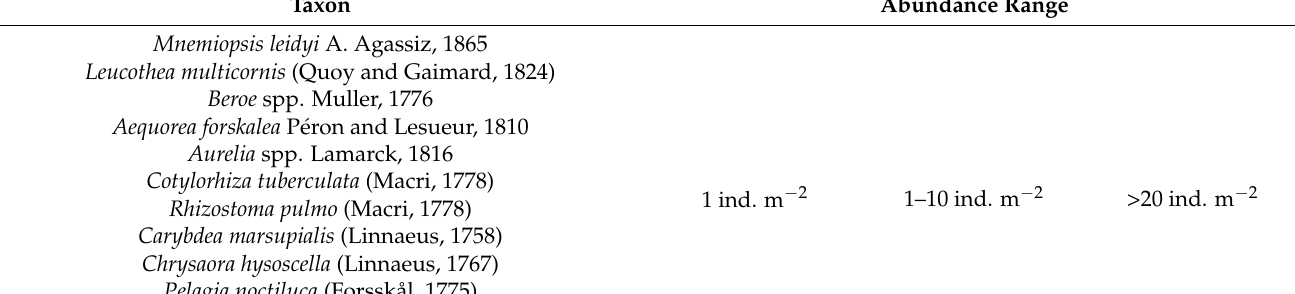
Table 1. List of the taxa that can be reported with avvistAPP and their selectable abundance range. Taxon Abundance